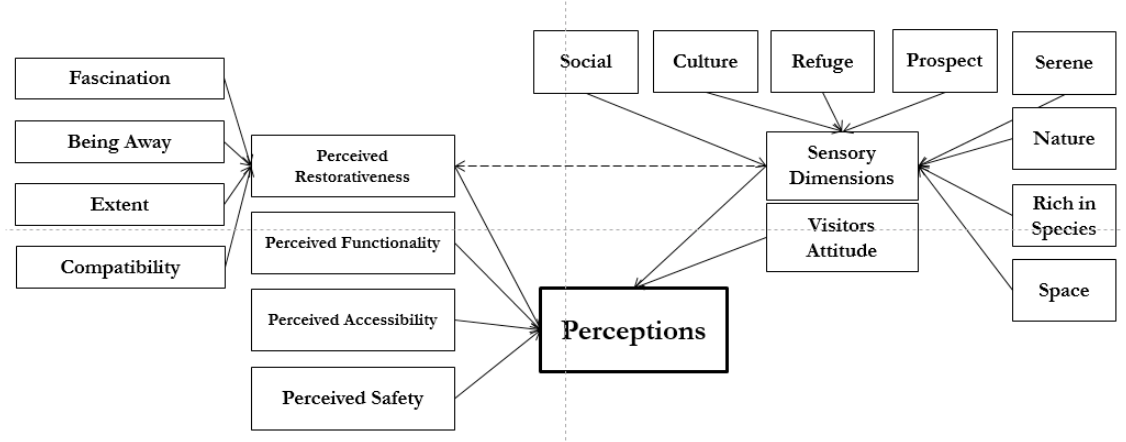
Figure 7: Perception of greenspaces